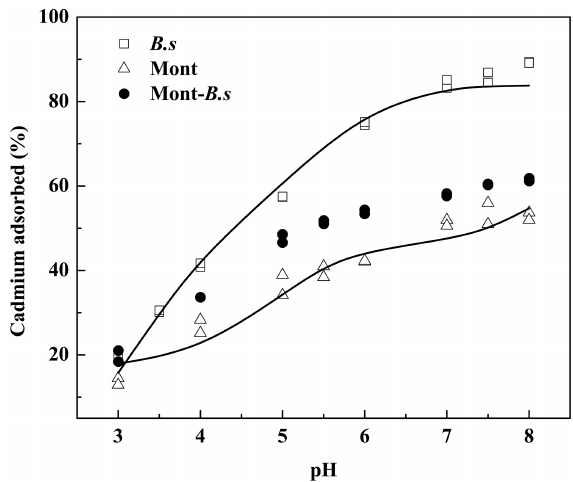
Figure 2. Adsorption of Cd(II) to montmorillonite, B. subtilis , and montmorillonite– B. subtilis composite as a function of pH in the presence of 0.01MNaNO 3 (symbols are data points and lines are model fits). The sorbent and initial Cd concentration is 1gL − 1 and 10ppm, respectively.